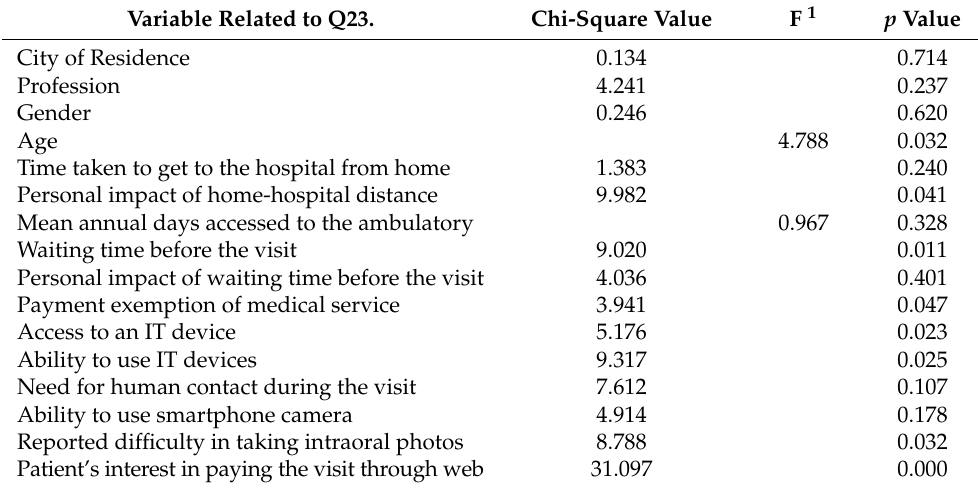
Table 3. Summary of bivariate statistical analysis carried out considering as dependent variables Question